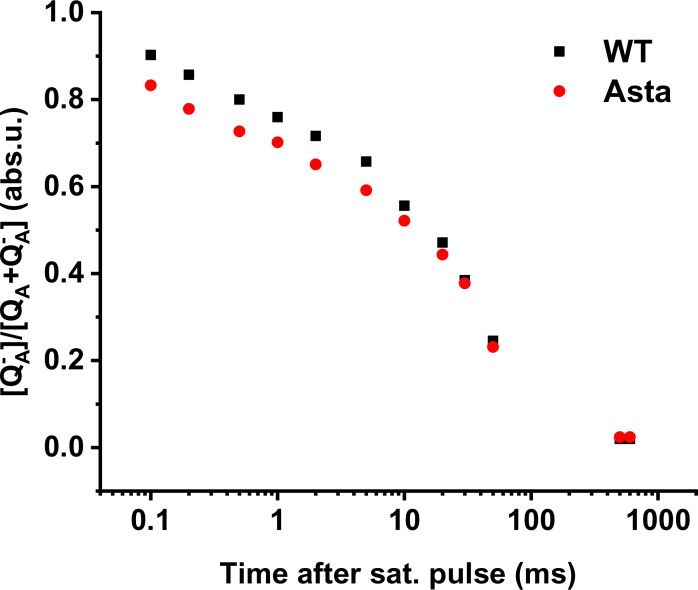
QA- reoxidation kinetics.The figure shows the time course of the reoxidation of the primary stable PSII electron acceptor, QA-, during the dark period following a saturating pulse. The fluorescence was probed between 0.1 and 600 s of darkness following a 500 ms exposure to 3500 µE m−2 s−1 red light. The decrease of fluorescence was recalculated to represent the QA- concentration (see Materials and methods for details).